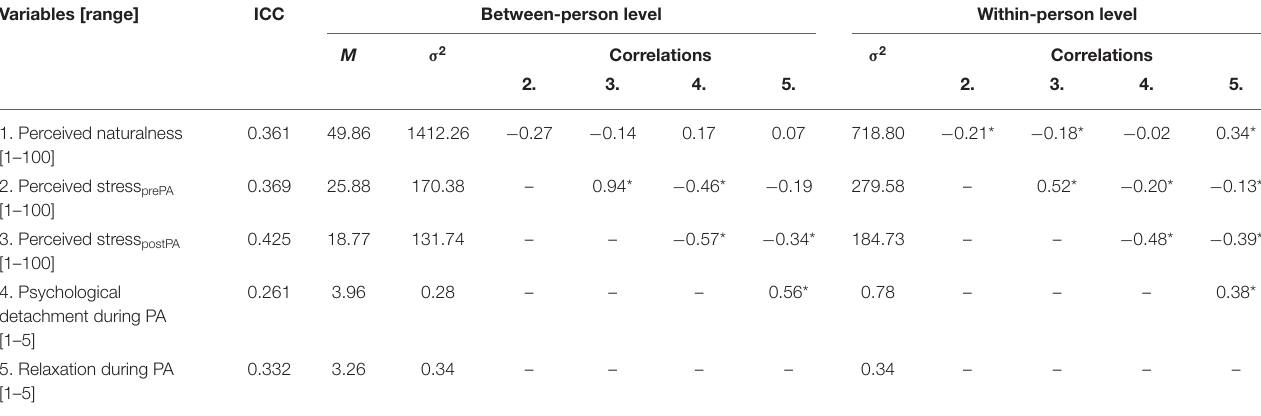
TABLE 1 | Descriptives of the study variables: Intraclass correlation coefficients (ICC), means (M) , variances ( σ 2 ) and correlations (* p < 0.05). Variables